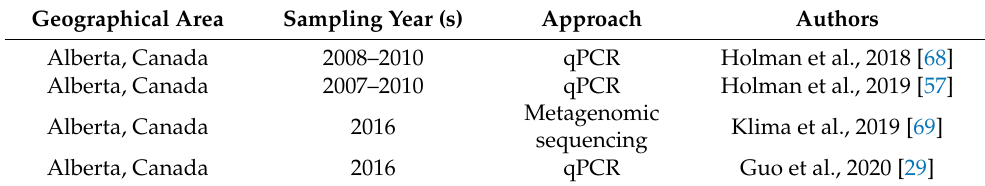
Table 5. Summary of the North American studies that used culture-independent approaches to investigate antimicrobial resistance in the microbiota of the respiratory tract of feedlot